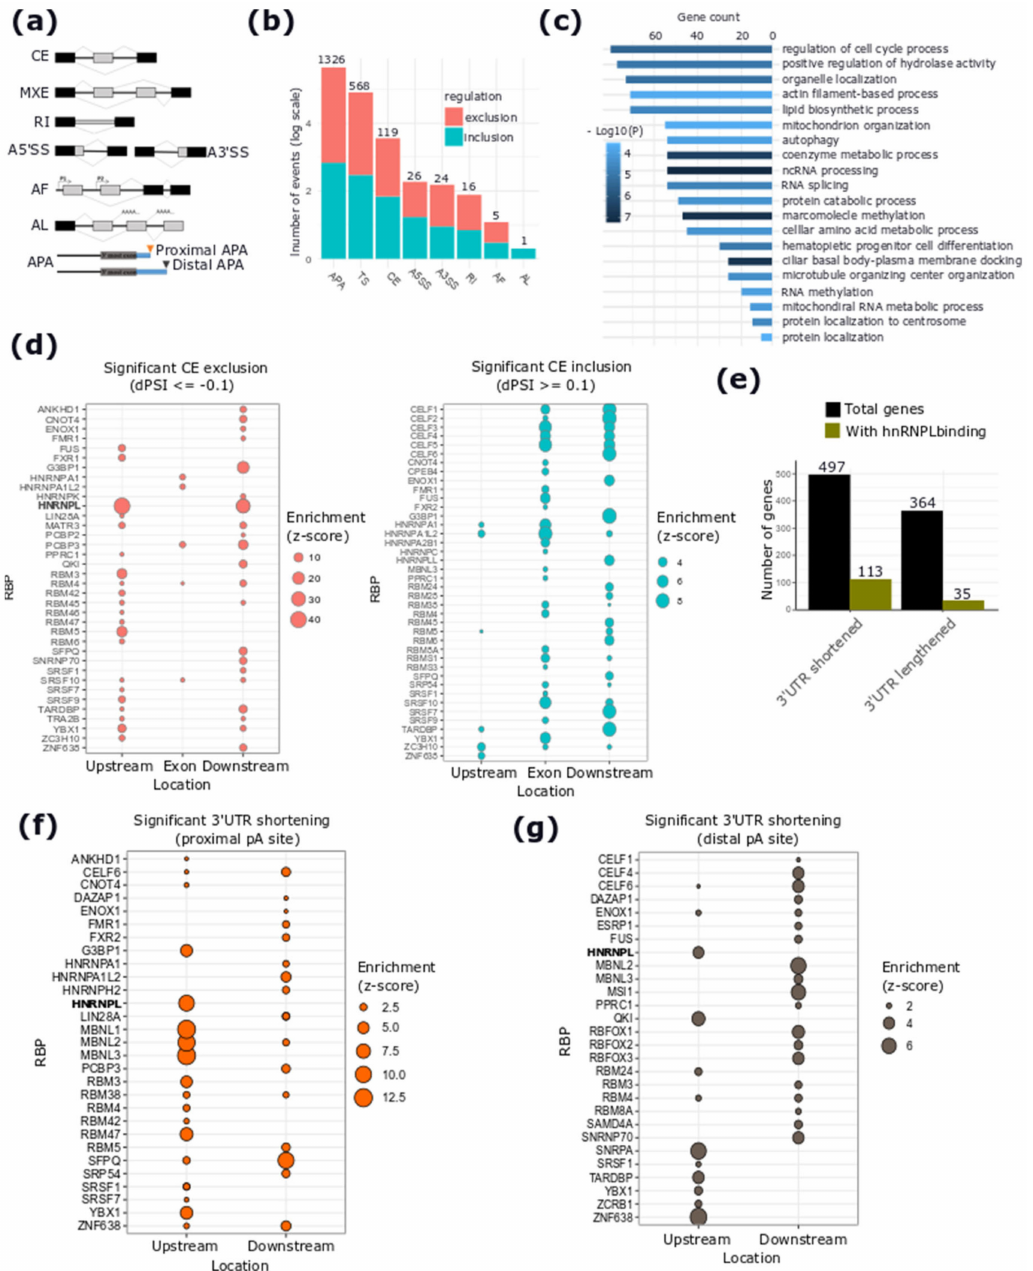
Figure 5. Alternative splicing (AS) changes upon DSCAM-AS1 silencing and prediction of binding motifs for RNA-binding proteins (RBPs). ( a ) Schematic depiction of the di ff erent classes of AS events analyzed using Whippet. Exon Skipping (ES); Mutually Exclusive Exons (MXE); Intron Retention (IR); Alternative 5 (cid:48) (left) and 3 (cid:48) (right) Splice Sites (ASS); Alternative First Exons (AF); Alternative Last Exons (AL); Alternative PolyA (APA) site; tandem Transcriptional Start Sites (TS). ( b ) Number of significant AS events per type and direction of regulation (inclusion or exclusion). ( c ) GO-enriched terms